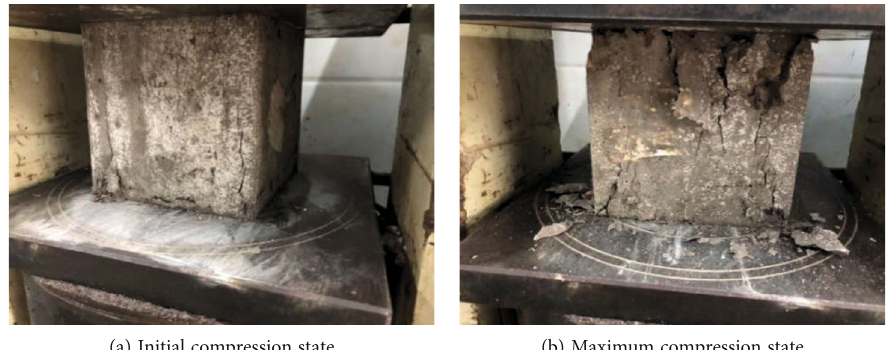
Figure 6: Compression failure of RAC with 60% coarse crushed clay